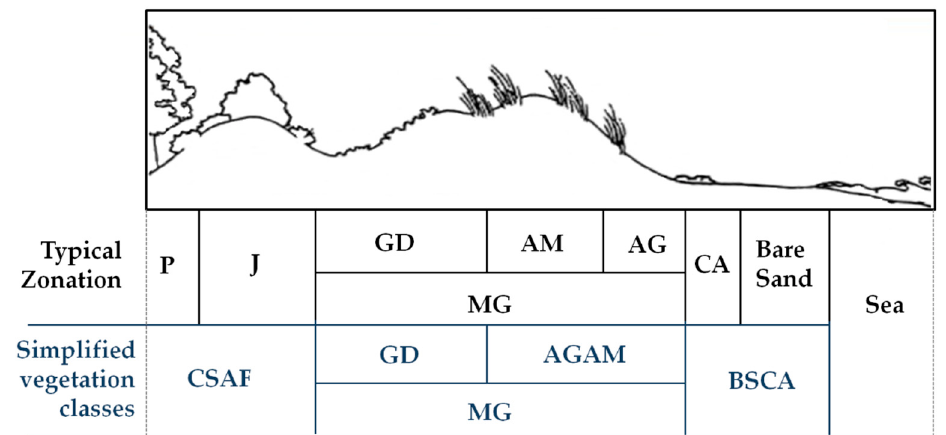
Figure 2. Schematic representation of the typical vegetation zonation [34] and the five simplified vegetation classes adopted in the present study after the in-situ botanical survey. For abbreviations, see main text.